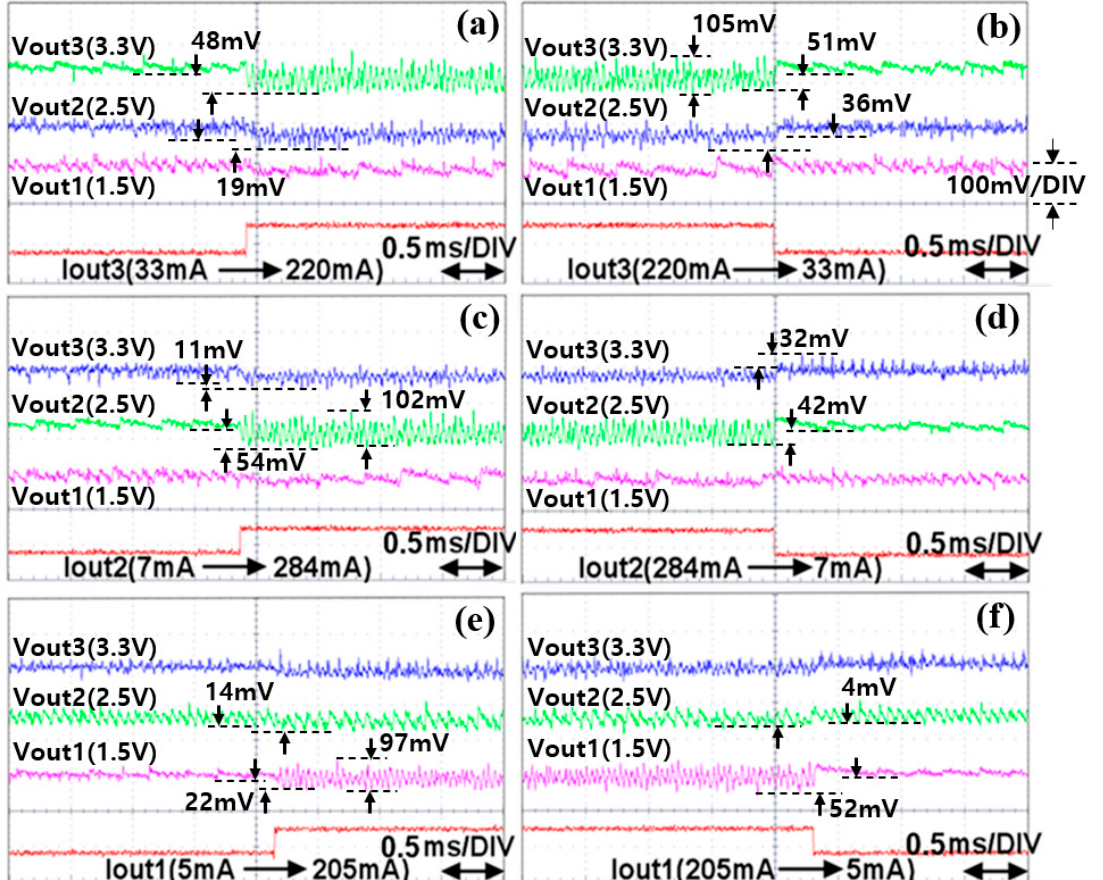
Figure 13. Measured transient waveforms of outputs, when one of output load–current changes abruptly, for all cases supply voltage V g is 2 V. For each figure, the out load current changed as indicated. Load current of output 3 was changed from 33 to 220 mA ( a ), from 220 to 33 mA ( b ). The load current of output 2 changes from 7 to 284 mA ( c ), and from 284 to 7 mA ( d ). For Figure ( e ) and Figure ( f ), load current of output 1 changes from 5 to 205 mA ( e ) , and from 205 to 5 mA ( f ), respectively.